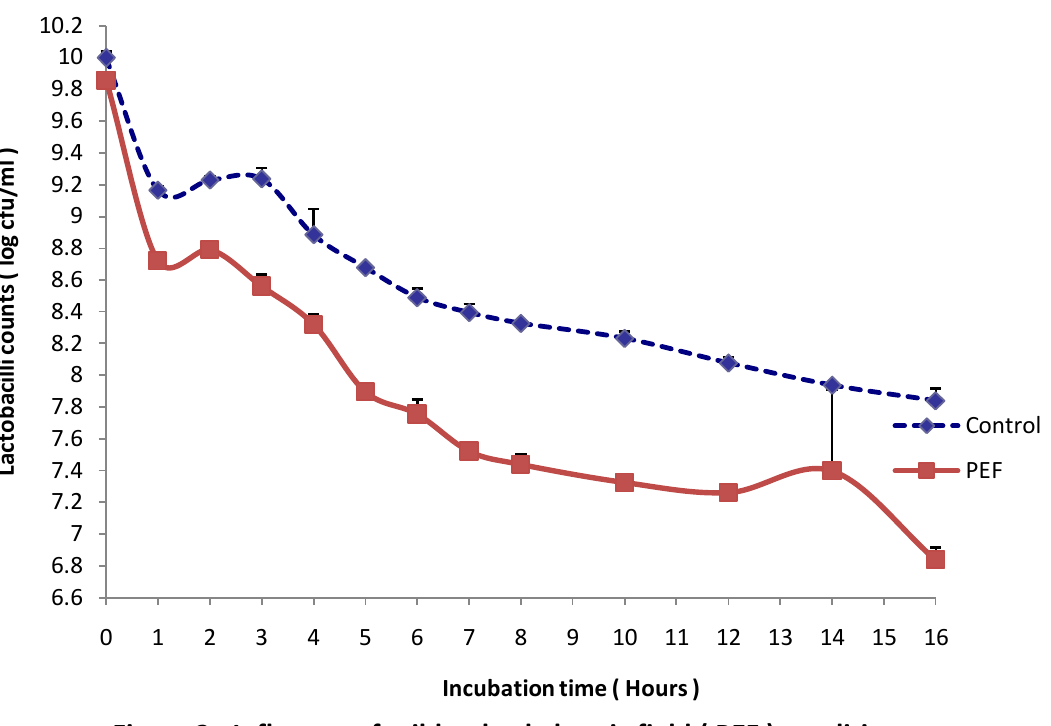
Figure 3 : Influence of mild pulsed electric field ( PEF ) conditions on the bile tolerance of Lactobacillus delbrueckii ssp bulgaricus